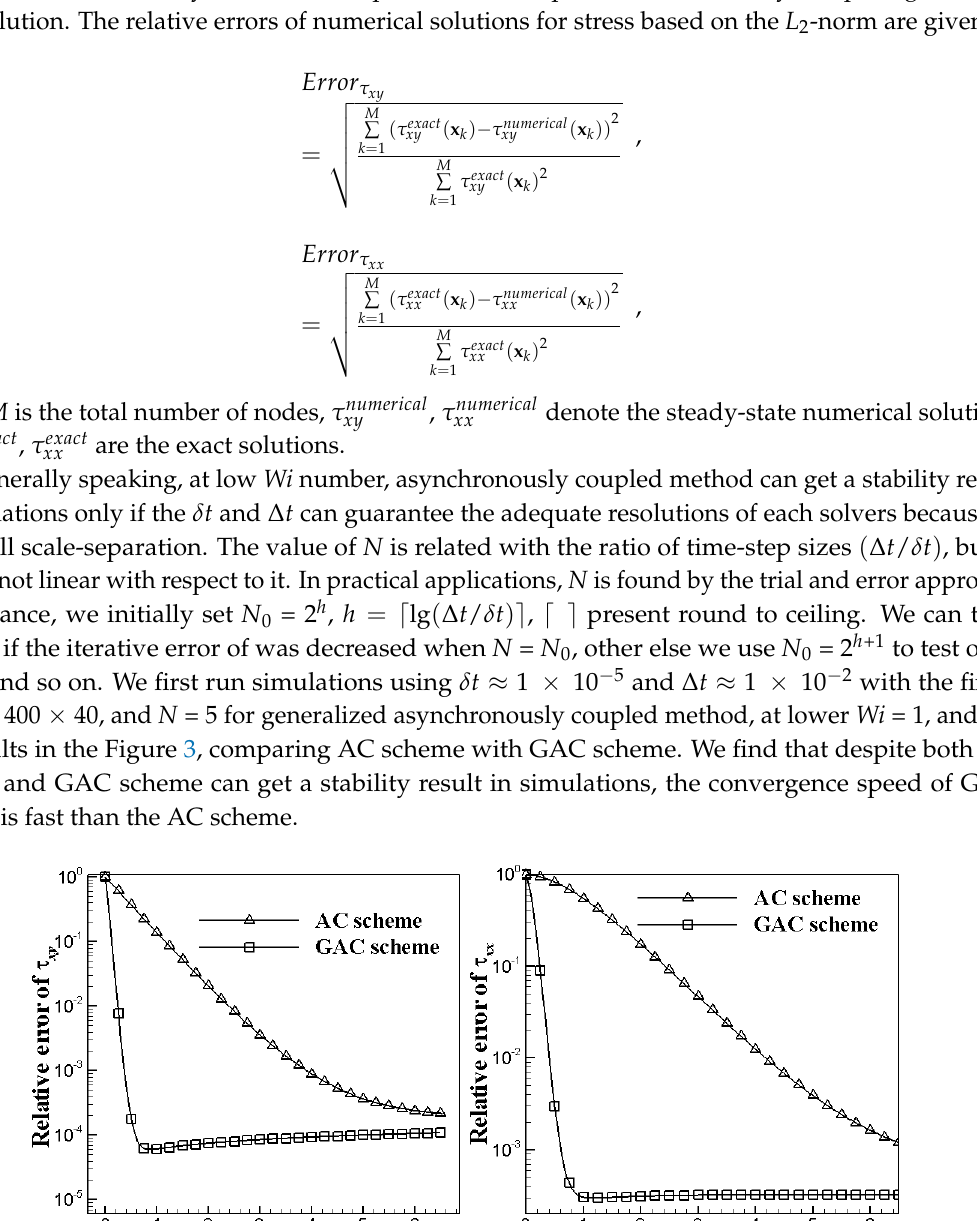
Figure 3. Comparison of the relative L 2 -error of τ xy and τ xx for y at position x = 5 at Wi = 1.0 with β = 0.5 and Re = 1.0, respectively.